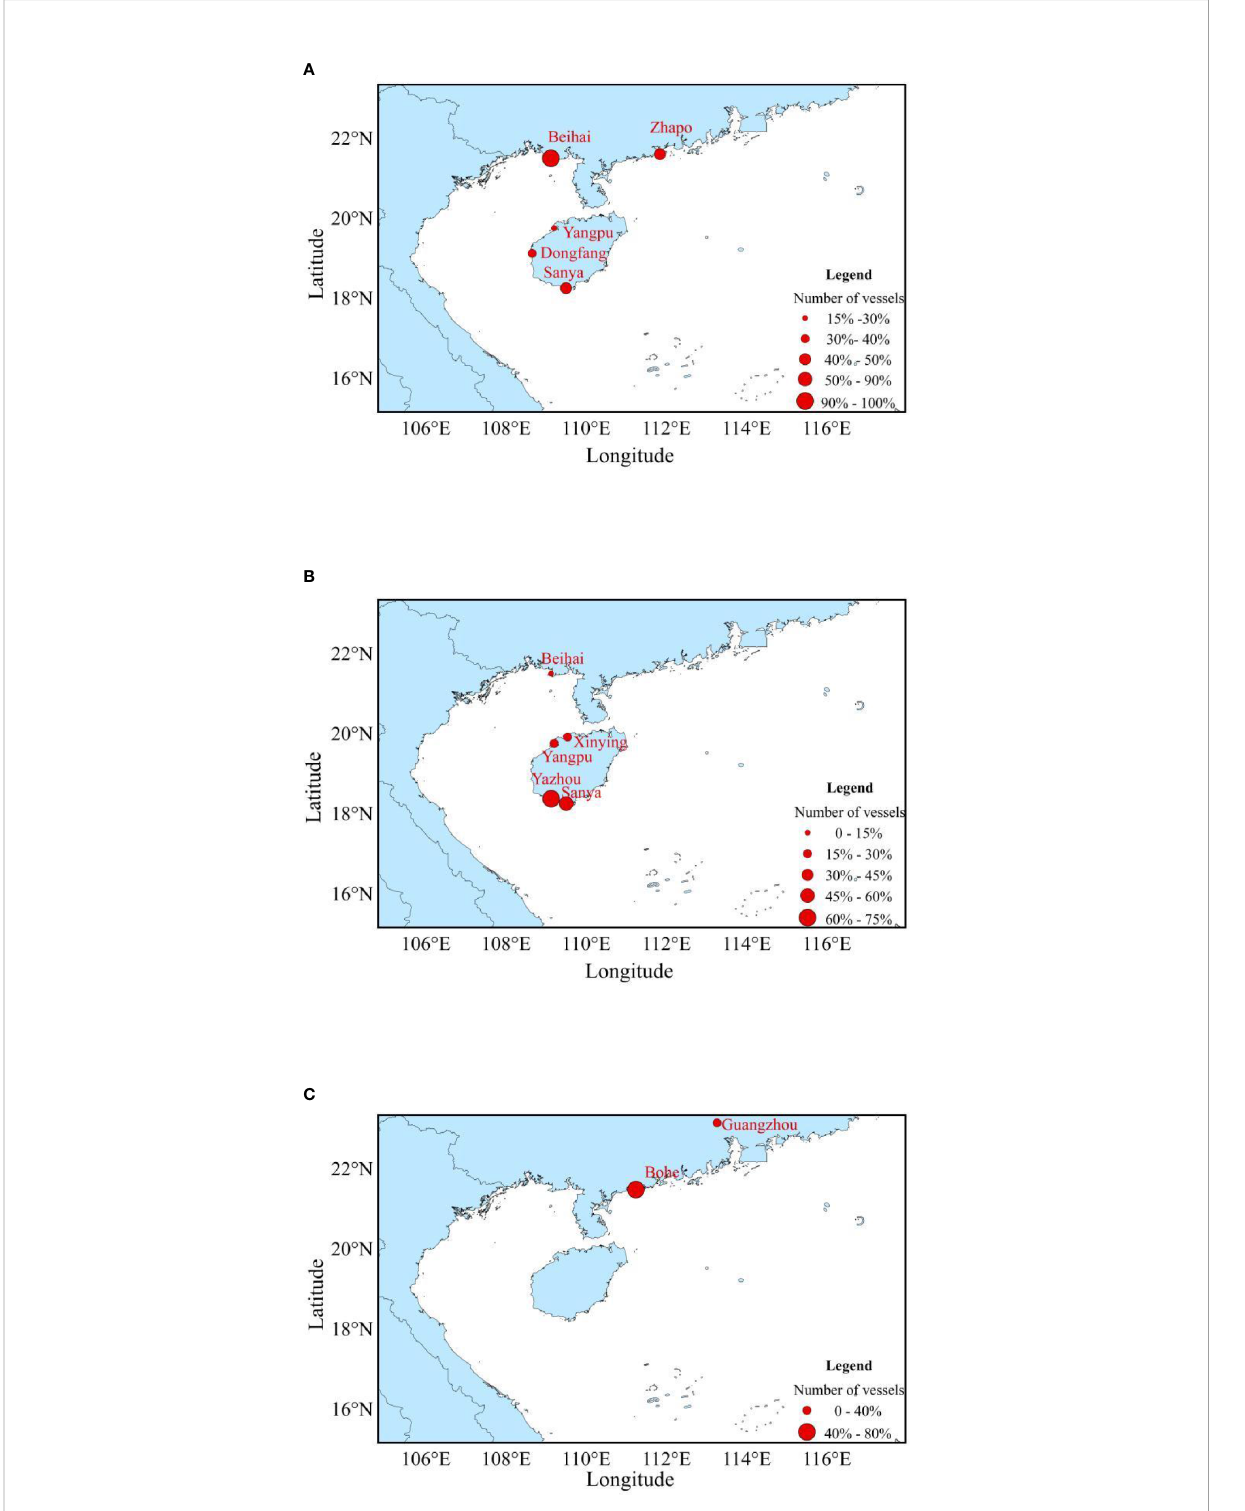
FIGURE 9 Trajectory of the large-size light falling-net vessels from vessel monitoring system records. Shown are the main ports for the fi shing vessels of Guangxi (A) , Hainan (B) , and Guangdong (C)